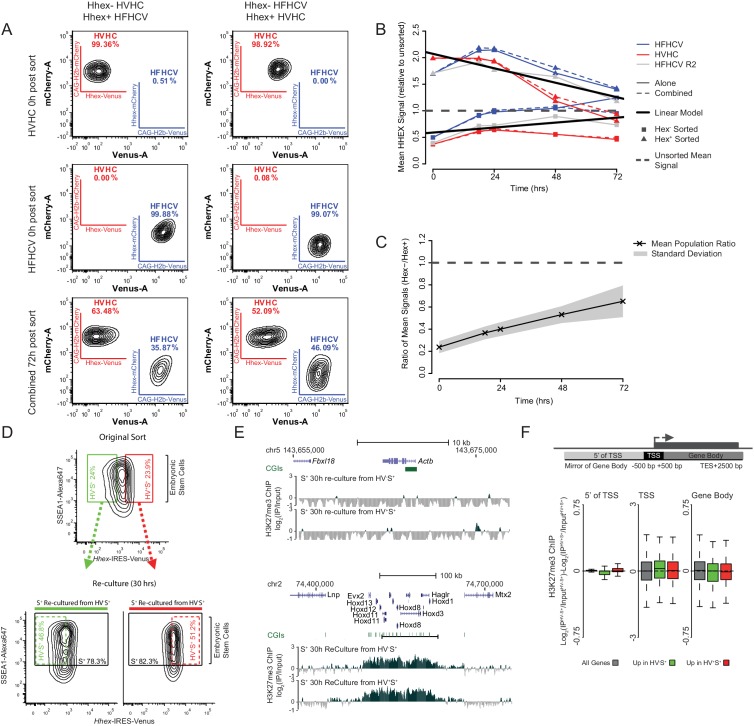
Differential gene-body H3K27me3 and the re-equilibration dynamics of Hhex defined lineage priming.(A) FACS density plots showing the primed cell populations isolated from the HVHC and HFHCV reporter cell lines (Hhex expression monitored by venus and cherry expression respectively; see materials and methods for details) and the pluripotency cell surface marker SSEA1. To monitor the rate at which these populations return to equilibrium, Epi- and PrEn-primed cells were isolated from each reporter line (upper panels) and re-cultured either individually or in combination for a total of 72 h (bottom panel). In both cases a lineage reporter, either H2b-mCherry (HVHC) or H2b-Venus (HFHCV), expressed at an order of magnitude higher levels than the Hhex reporter allows the identification of specific cell lines, regardless of Hhex expression (e.g. compare the Cherry expression in the HVHC cells on the top line, to those derived from the HFHCV, second line). This enables the identification of originating cell/population from which Hhex is expressed in mixing experiments. (B) Summary plot showing the population averaged Hhex expression when the Epi- and PrEn-primed cells (squares and triangles respectively) are re-cultured either alone or in combination (solid and dashed coloured lines respectively). Hhex expression values for each population represent the mean population signal relative to the initial unsorted mean value. (C) Summary plot showing the arithmetic mean Hex- vs. Hex+ ratio plotted against time in culture post-sorting. The standard deviation for this data is highlighted in grey. (D) FACS density plots showing the Hhex and SSEA1 profiles of Epi- and PrEn primed populations (green and red gates respectively) isolated from HV5.1 reported ESCs. Shown are the primed populations at the point of sorting (upper panel) and following 30 h of re-culture (lower panel). H3K27me3 ChIP was performed on the total SSEA1 positive gate (S+; black box) from the re-cultured populations (see E and F). (E) Example H3K27me3 ChIP-seq profiles (log2(IP/Input)) for Actb and Hoxd (Control Loci) for the 30 h re-cultured populations shown in (D). Coordinates are for the mm9 mouse genome assembly. (F) Schematic representation of the stratification used to bin H3K27me3 signal with respect to genes (upper panel) and boxplots showing the ratio of H3K27me3 ChIP-seq signal between the two re-cultured primed ESC populations from formaldehyde cross-linked ChIP. The presented data was generated from cells re-cultured from the sorts presented in Figure 2B. Two-sample permutation tests (oneway test) identified no significant differential H3K27me3 levels between the re-cultured populations.